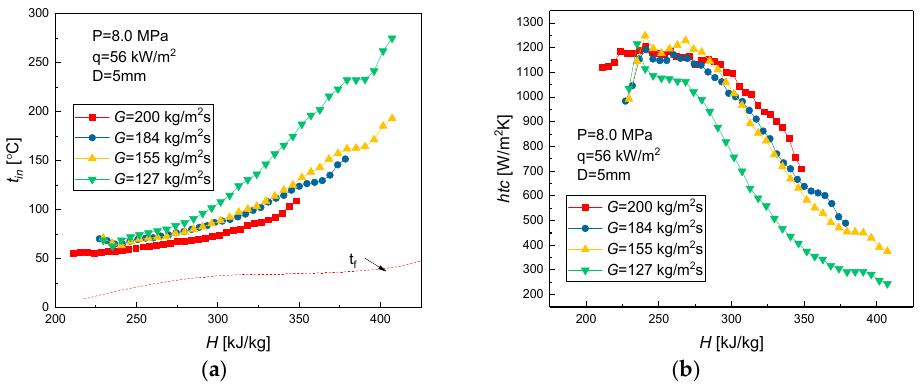
Figure 9. Variations in inner-wall temperatures and heat transfer coefficients for various bulk enthalpies at different mass fluxes and the pressure of 8.0 MPa. ( a ) Temperature; ( b ) Heat transfer coefficient.